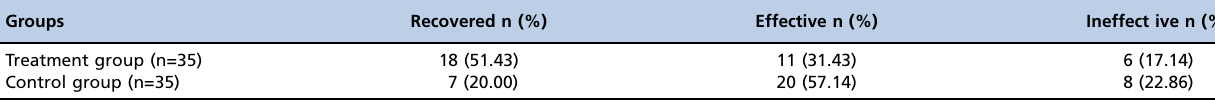
Table 3 - Clinical curative effect at 3 months after treatment.